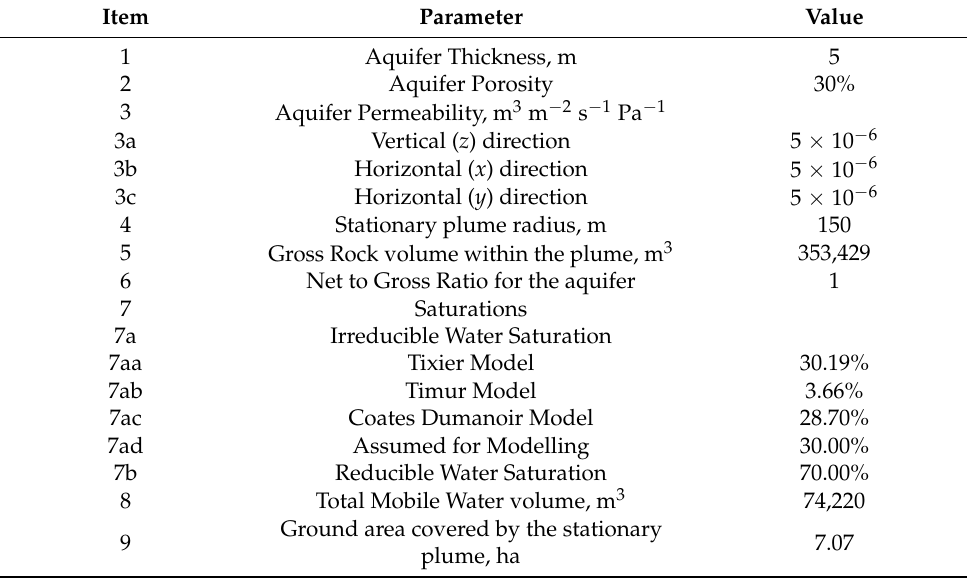
Table A1. Parameters associated with the hydrodynamic stationary plume. Item Parameter